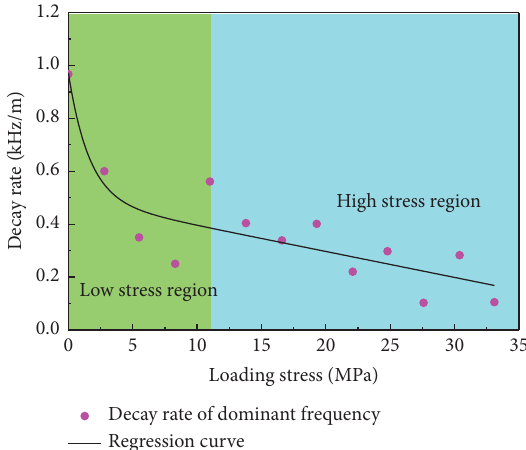
Figure 7: Variation tendency of decay rate of dominant